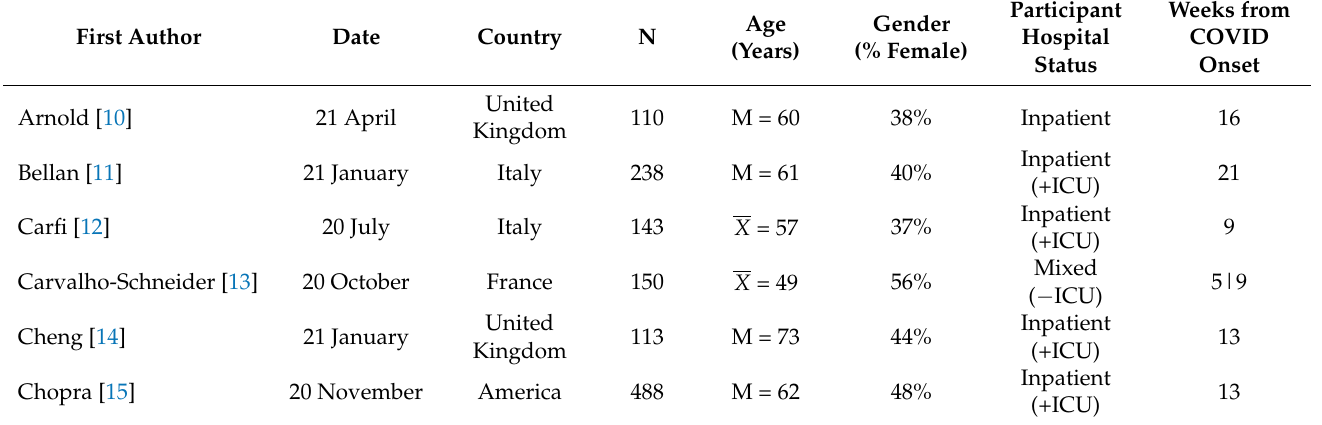
Table 2. Demographics of Included